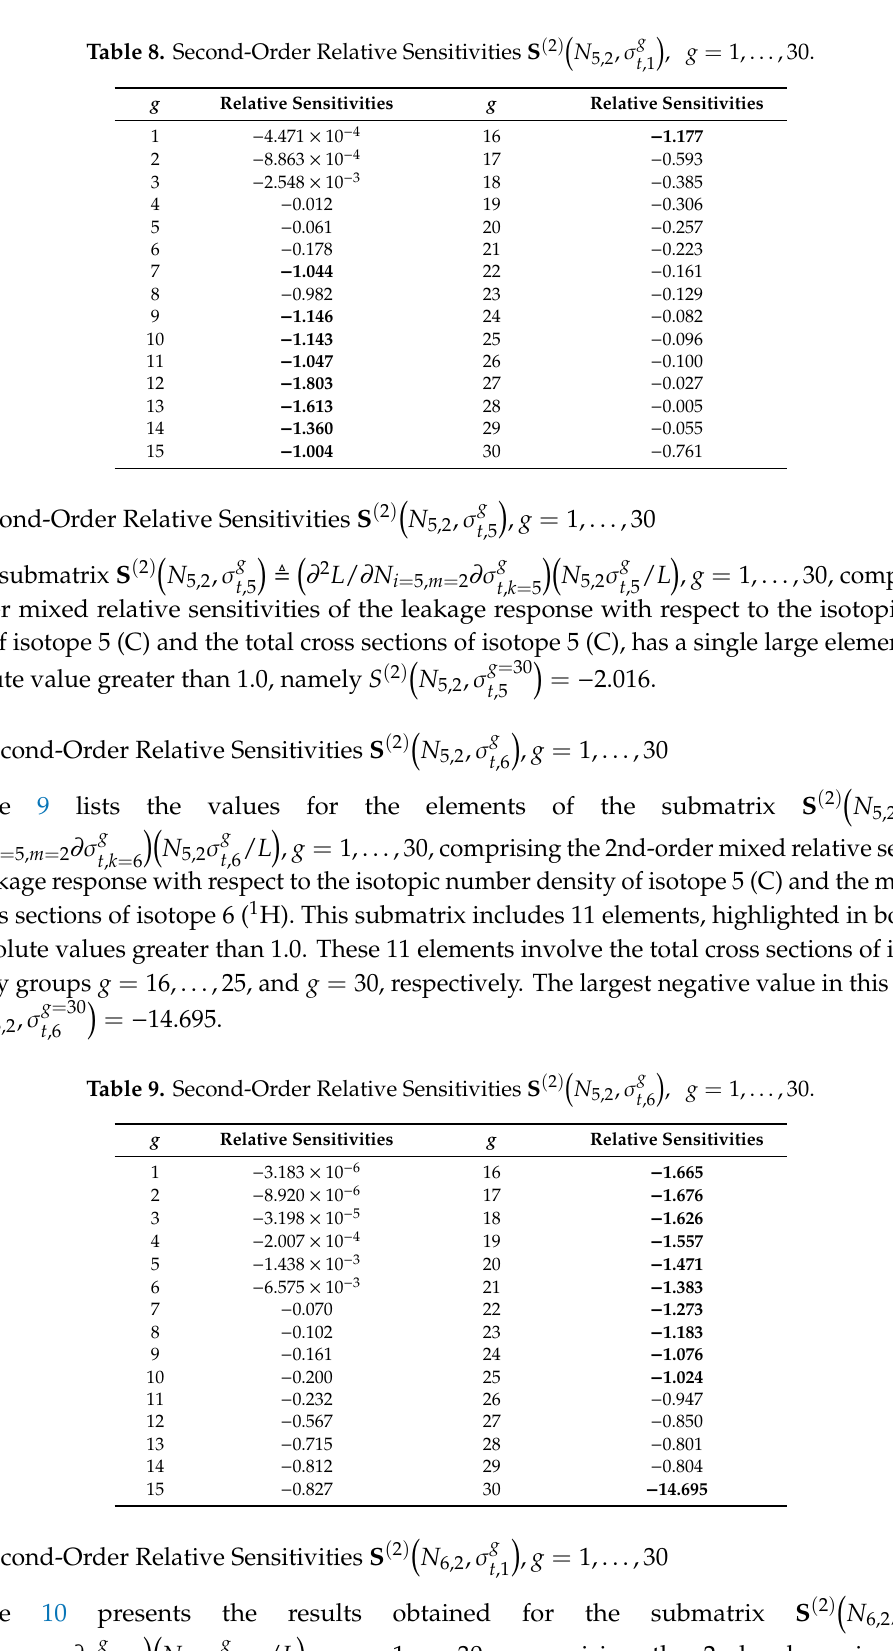
Table 10 presents the results obtained for the submatrix S ( 2 ) (cid:16) (cid:17)(cid:16) (cid:17) ∂ 2 L / ∂ N ∂σ g N 6,2 σ g / L , g = 1, . . . , 30, comprising the 2nd-order mixed relative i = 6, m = 2 t , k = 1 t , k = 1 sensitivities of the leakage response with respect to the isotopic number density of isotope 6 ( 1 H) and to the microscopic total cross sections of isotope 1 ( 239 Pu). As highlighted in bold in this